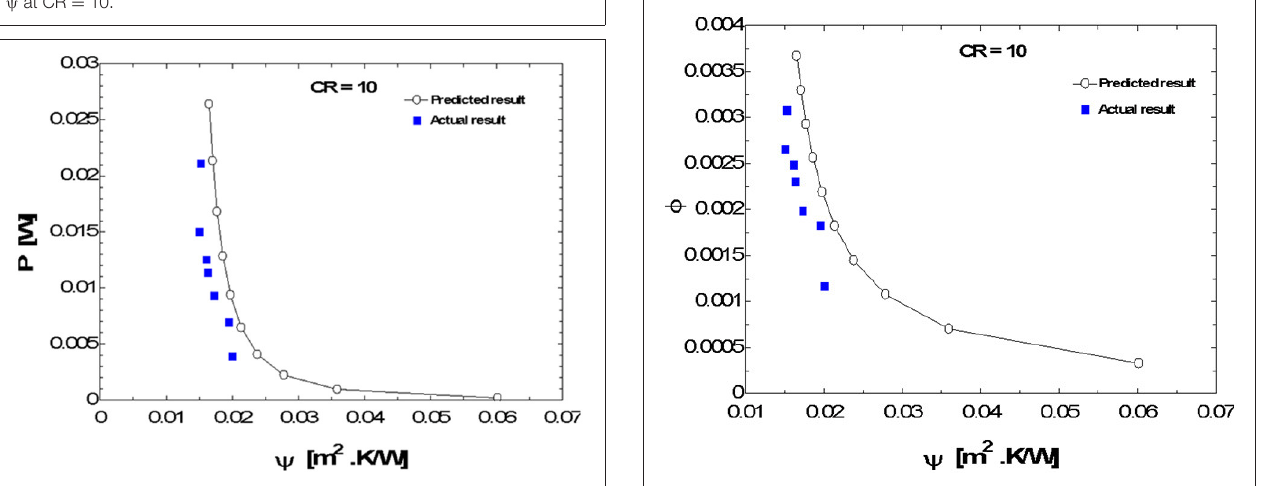
FIGURE 8 | Power output P vs. system parameter ψ at CR = 10. FIGURE 9 | Conversion efficiency, Φ , vs. system parameter ψ at CR =